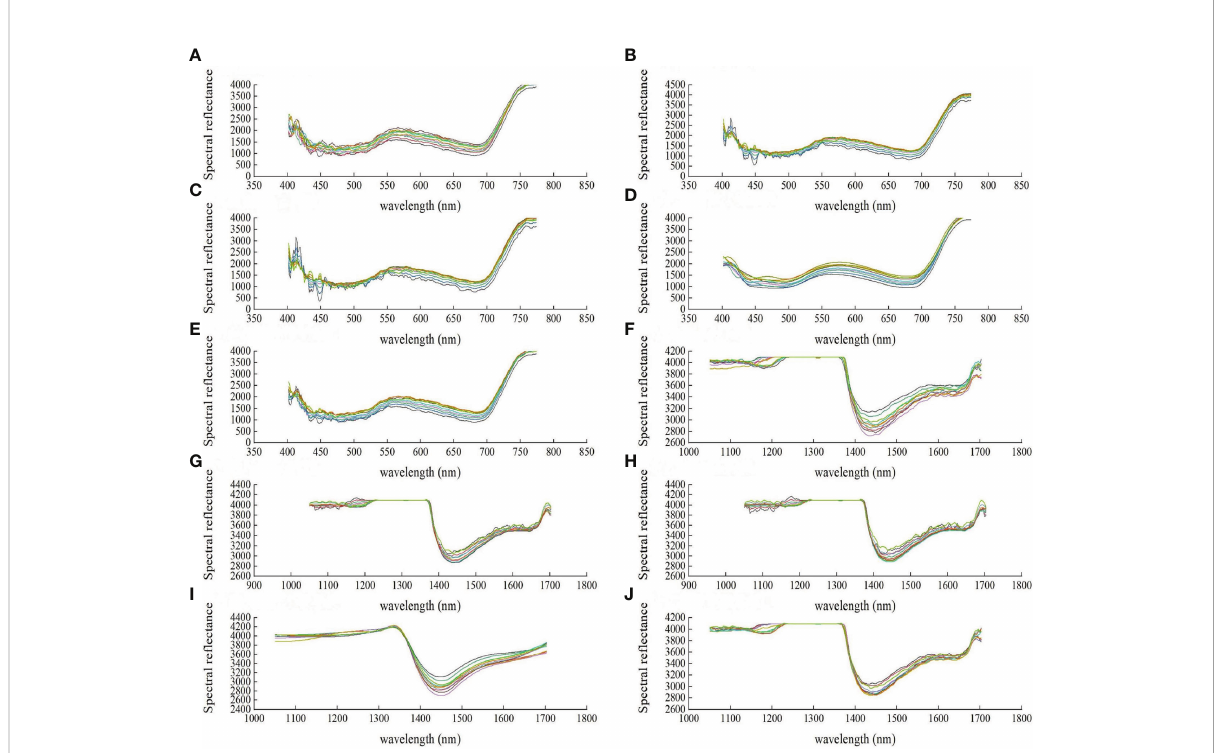
FIGURE 3 Spectral tlas of some cucumber disease amples under different preprocessing methods of hyperspectral data. (A) Visible original spectrum, (B) Visible spectrum SG7 point smoothing, (C) Visible spectrum SG9 point smoothing, (D) Visible spectrum discrete wavelet transform, (E) Visible spectrum moving window sliding, (F) Near infrared original spectrum, (G) Near infrared spectrum SG7 point smoothing, (H) Near infrared spectrum SG9 point smoothing, (I) Near infrared spectrum discrete wavelet transform, (J) Near infrared spectrum moving window